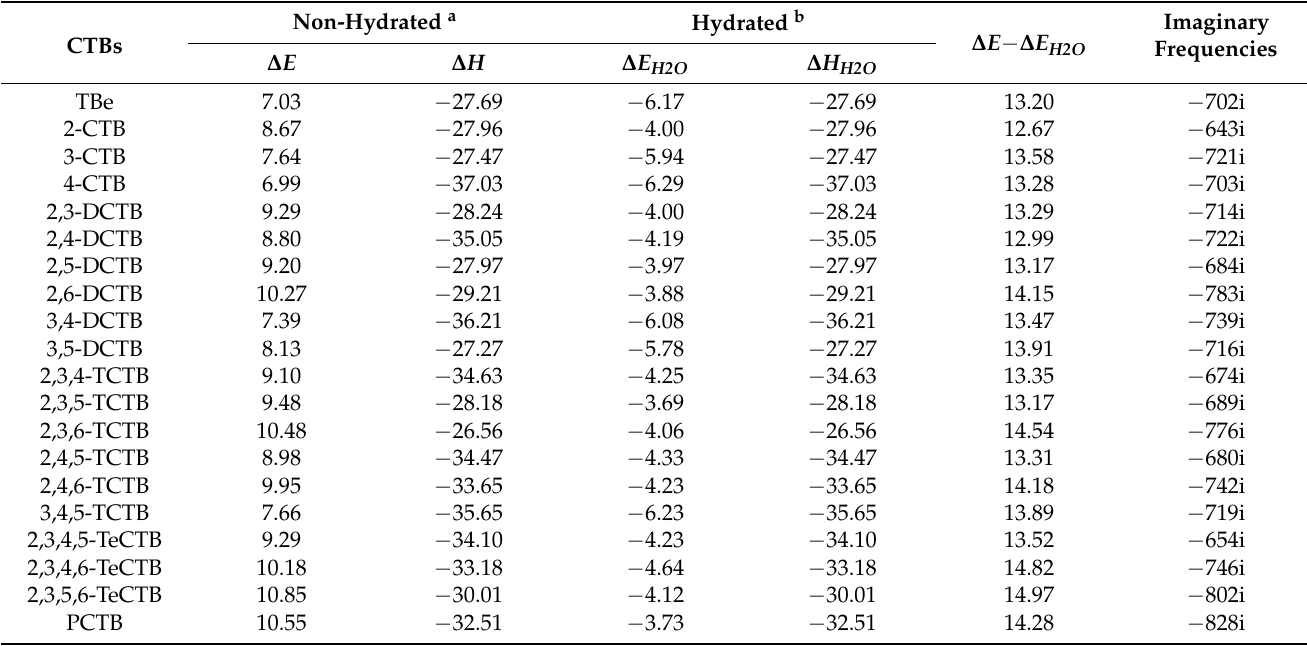
Table 3. Imaginary frequencies (in cm − 1 ) in transition states, potential barriers ∆ E (in kcal mol − 1 ), and reaction heats ∆ H (in kcal mol − 1 ) of the H abstraction of CTBs by · OH radical in hydrated and non-hydrated cases, respectively. ∆ E and ∆ H are calculated at 0